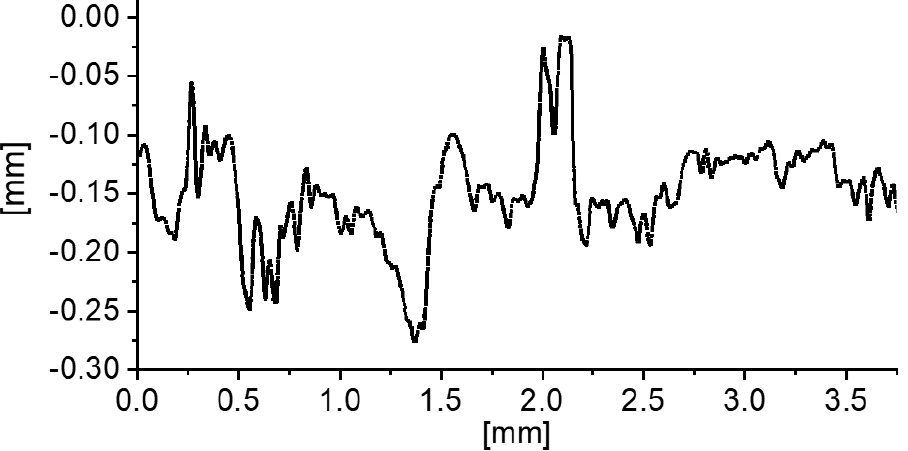
Figure 14. The bottom surface profilometry of the Ti:Sapphire ablation incision for the mesosiderite JaH